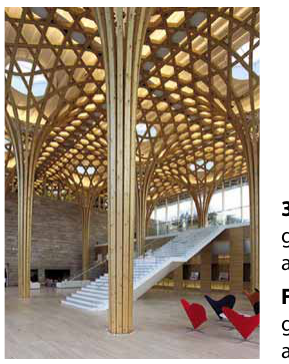
archit. biurai „AWP“ ir „Atelier Oslo“, 2010 m. Fig. 38. Shining pavilion in Sandnes, Norway, archit. offices “AWP” and “Atelier Oslo”, 2010